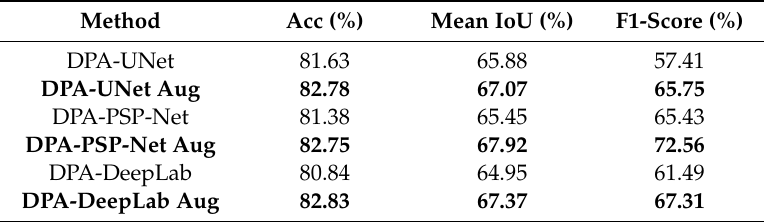
Table 6. DPA-Net performance using the original dataset and the augmented dataset.